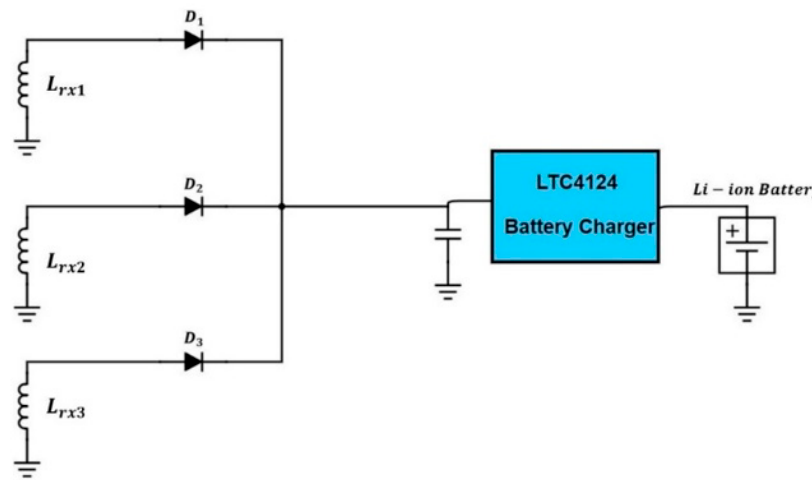
Figure 6. Circuit diagram of the RX coil array for smart